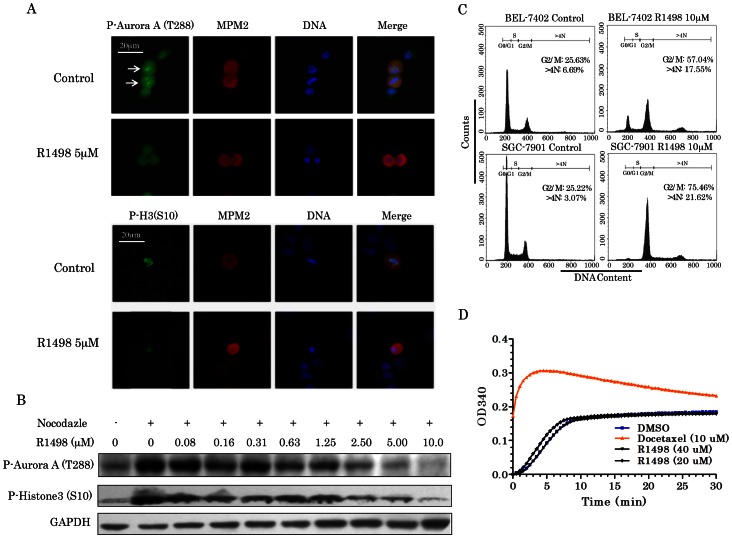
R1498 targets Aurora kinases in cells.(A) SGC-7901 gastric cancer cells were treated with 5 µM R1498 for 24 h, then fixed and stained for phospho-Aurora A(T288) (green), MPM2 (red) and DNA (blue). MPM2 was used to locate the mitotic cells. Bright green foci pointed by white arrow heads indicated the high level of phospho-Aurora A(T288) in centromere (upper panel). R1498 treated SGC-7901 gastric cancer cells as above were stained for phospho-Histone H3(H10) (green), MPM2 (red) and DNA (blue) (lower panel). Representative images from 2 independent assays are shown. (B) R1498 treated SGC-7901 cells as above was subjected DNA analysis by flow cytometry via propidium iodide staining. The histograms were further analyzed by Modfit 3.0 for cell cycle distribution. The cells with DNA content more than 4N (>4N) mean aneuploidy caused by endoduplication. Representative histograms from 3 independent assays are shown. (C) SGC-7901 synchronized with nocodazole (300 nM) for 12 h were treated with various concentration of R1498, then lysed and subjected for western blot with corresponding antibodies. (D) In vitro tubulin polymerization assay was performed with R1498 and docetaxel, and the OD340 was measured and recorded in a time lapsed manner. Representative histograms from 2 independent assays are shown.